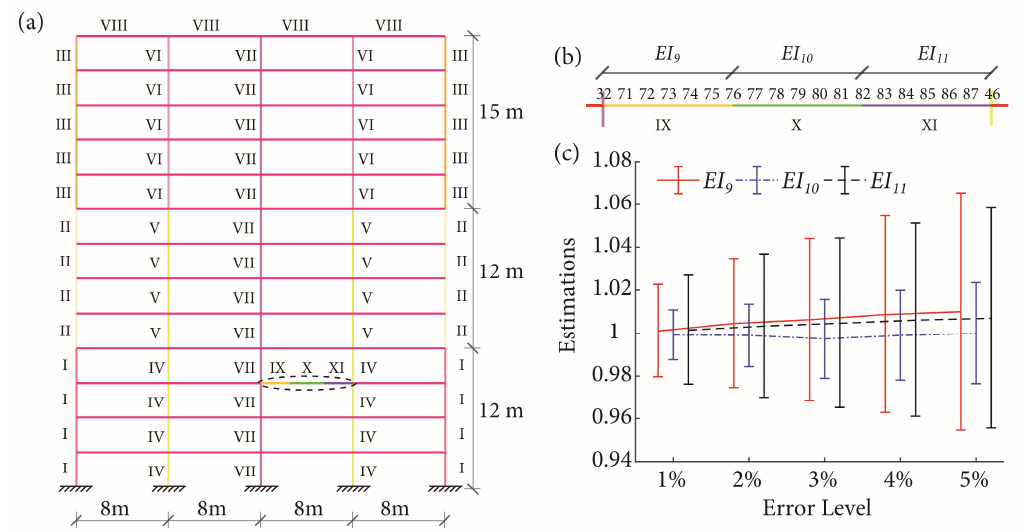
Figure 11. ( a ) The FEM of the high-rise building (adapted from [49]). ( b ) The FEM for the floor slab to be identified. ( c ) Error bar plot of the estimations of EI 9 – EI 11 .